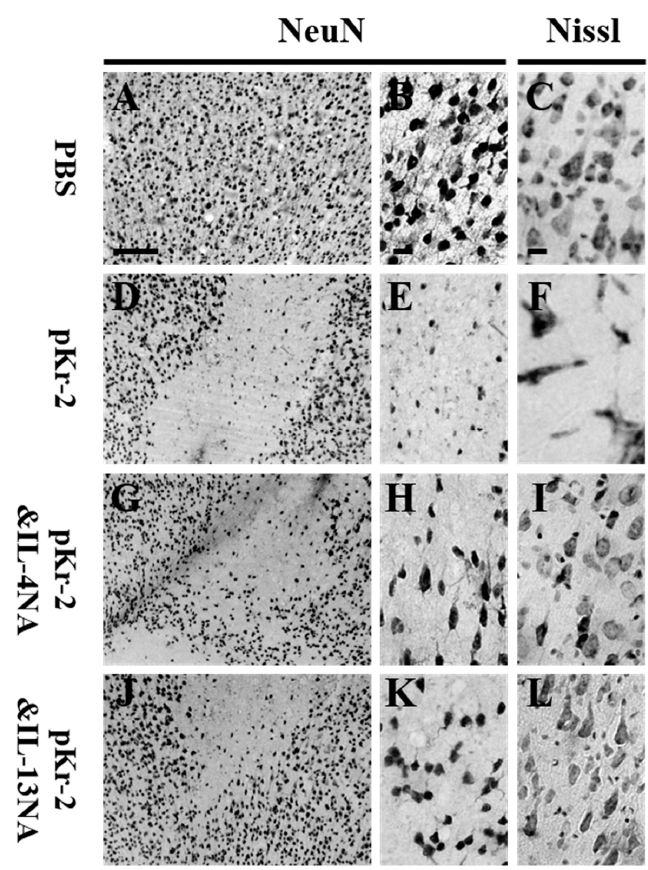
Figure 4. Neutralization of IL-4 or IL-13 prevents degeneration of cortical neurons in vivo in the pKr- 2-injected rat brain. ( A – L ) PBS (4 μ L; A – C ) or pKr-2 (48 μ g/4 μ L; D – F ) was unilaterally injected into cerebral cortex in the presence of IL-4NA (1 μ g; G – I ) or IL-13NA (1 μ g; J – L ). At 7 d post-injection, the coronal sections were selected and processed for NeuN ( A , B , D , E , G , H , J , K ) immunohistochemical staining or Nissl staining ( C , F , I , L ). ( B , E , H , K ) Higher magnification of A , D , G and J , respectively. Scale bars: 250 μ m ( A ) and 20 μ m ( B , C ). n = 4 to 6.